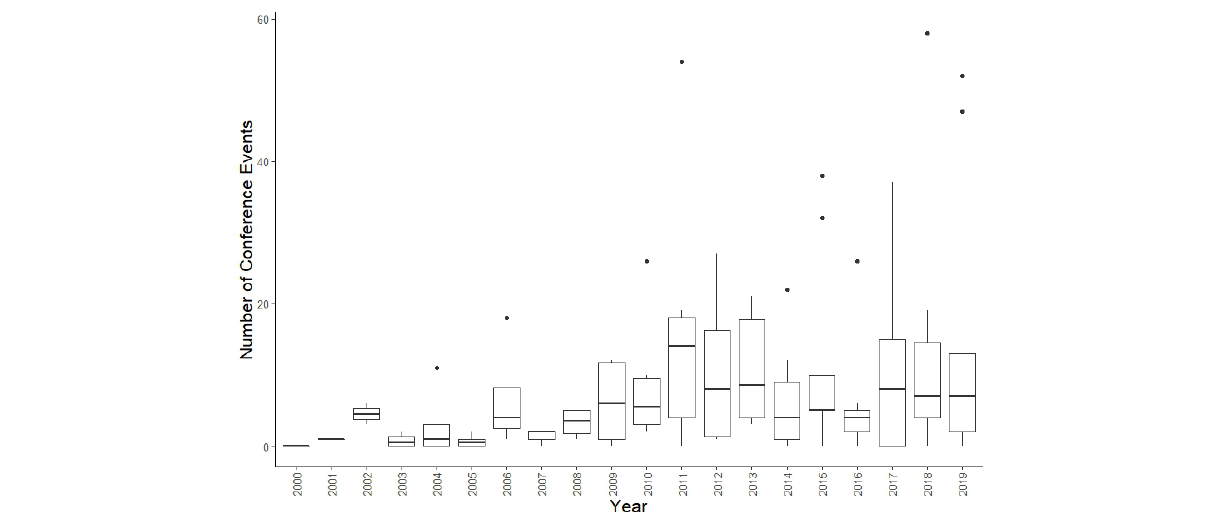
Fig. 2 . Distribution of disaster-related conference events across all sampled conferences from 2000 to 2019 (n = 113). The middle horizontal line represents the median, bars represent the first and third quartiles, vertical lines represent the minimum and maximum range relative to the quartiles, and dots are